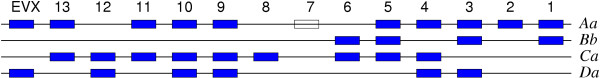
The pufferfish Takifugu rubripes has seven Hox clusters of which we use four in our computational example. The Evx gene, another homedomain transcription factor is usually liked with the Hox genes and can be considered as part of the Hox cluster. The paralogy groups are indicated. Filled boxes indicates intact Hox genes, the open box indicates a HoxA7a pseudogene [45].